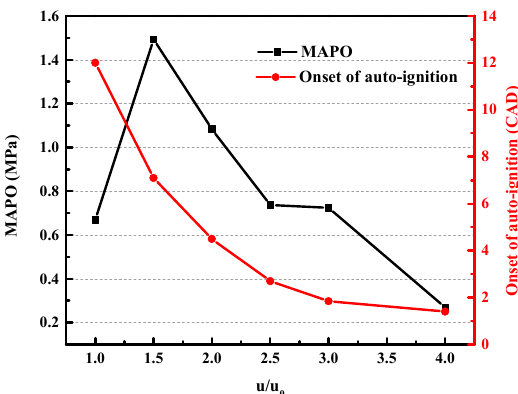
Figure 16. MAPO and onset of auto-ignition with different turbulence intensities.